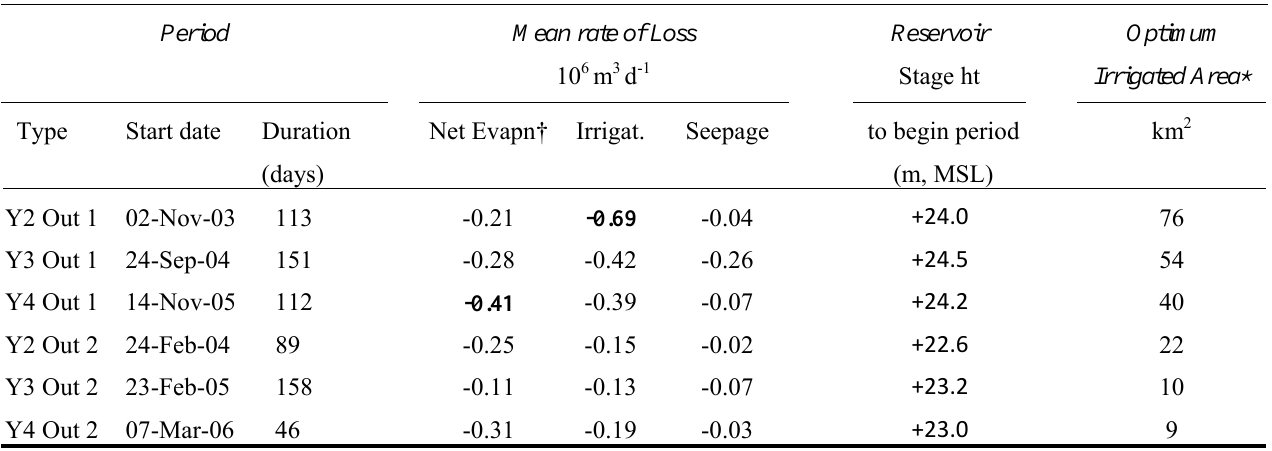
Table 5. Mean water losses and estimated irrigated area during